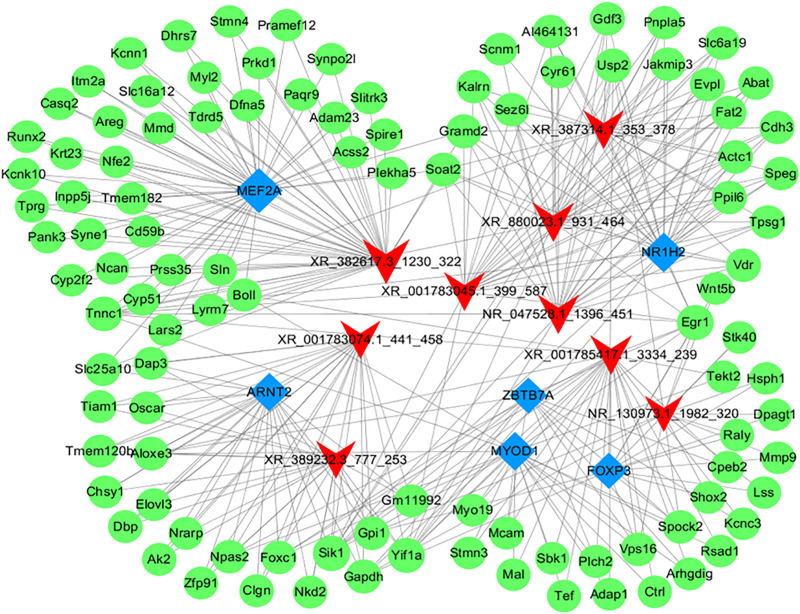
Network of the top 10 most related lncRNA-target-transcription factors. The co-expression networks of the lncRNA, target mRNA and transcription factor were constructed using Cytoscape software (version 3.5.1). Red arrowheads, lncRNAs; green diamonds, mRNAs; blue diamonds, transcription factors.